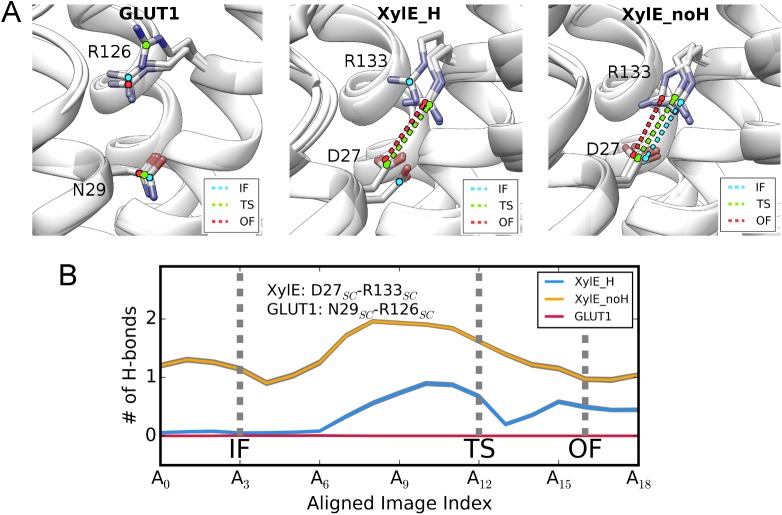
Local changes around protonation site.(A) The Asp27SC-Arg133SC/Gln29SC-Arg126SC interaction of XylE/GLUT1 in various conformational states. The interaction is highlighted as dashed lines only when the two interacting partners form close physical contact. The interaction is labeled in cyan, green and red for IF, TS and OF states, respectively. (B) The average number of H-bonds formed between the Asp27SC-Arg133SC/Gln29SC-Arg126SC interacting pairs along the aligned transition paths of GLUT1 (red), XylE_H (blue) and XylE_noH (yellow). The gray shadow around each curve represents standard deviation.